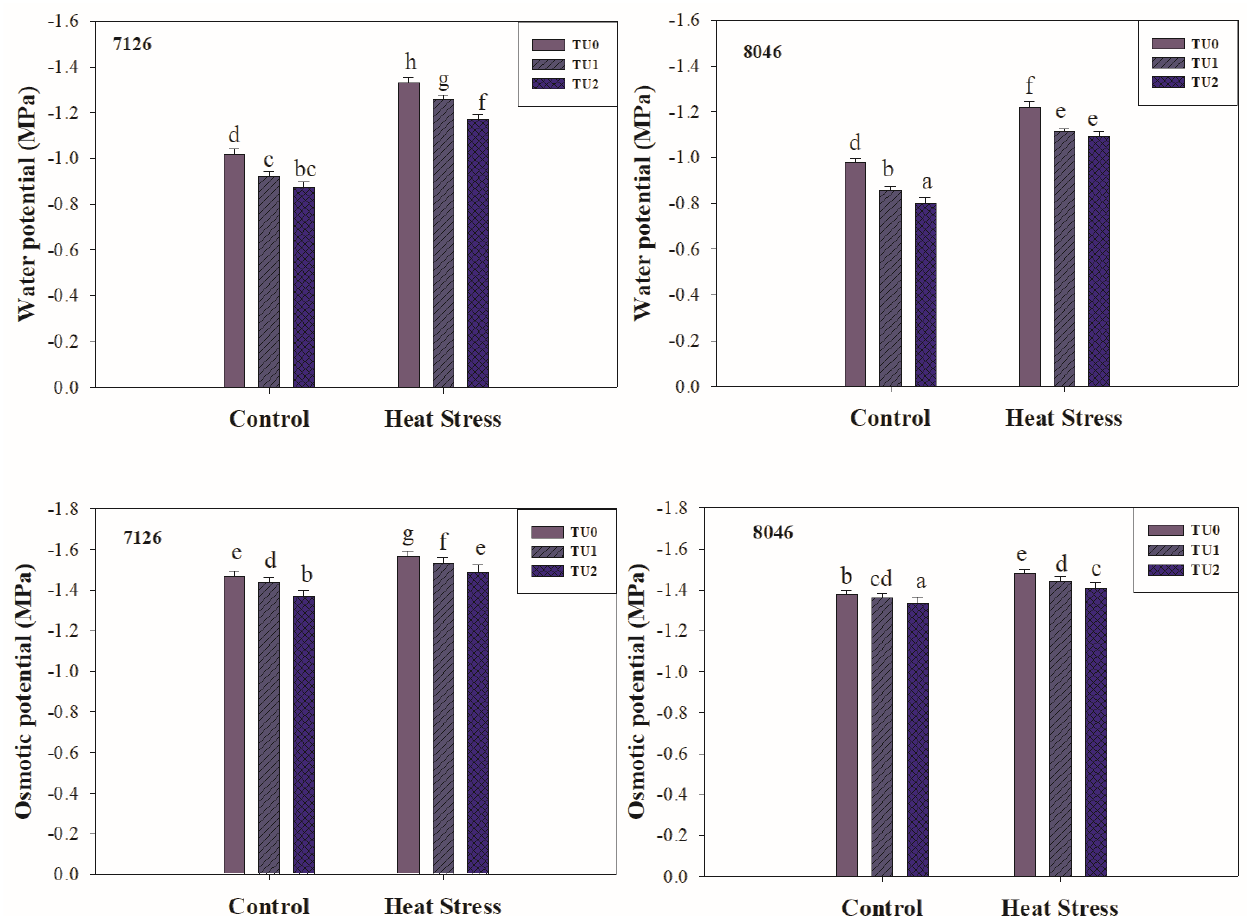
Figure 1. Impact of thiourea priming (TU 0 = control–no application, TU 1 = Water priming, TU 2 = Thiourea priming (500 ppm) and heat stress (32 °C) on water potential ( − MPa) and osmotic potential ( − MPa) on camelina genotypes 7126 and 8046. Error bars above means indicate the ± S.E. Means sharing the same letter in both varieties do not differ significantly at p ≤ 0.05.